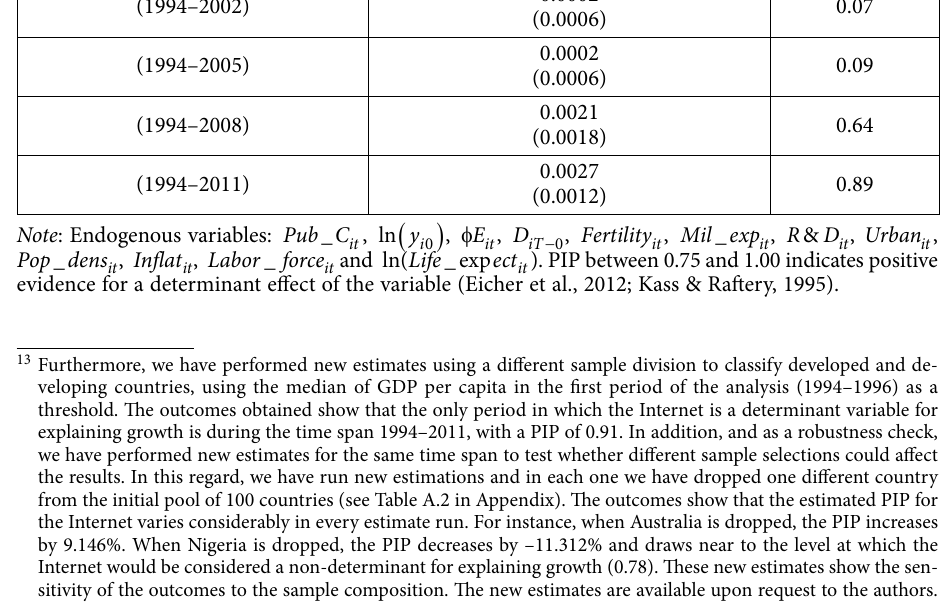
BPMA Whole Posterior Mean.